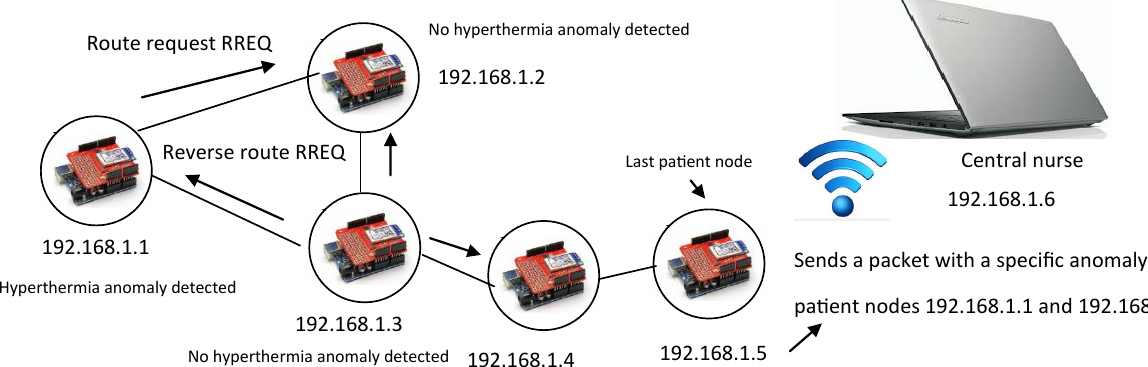
Figure 7. Specific anomaly detection via AODV ( ad hoc on-demand vector)